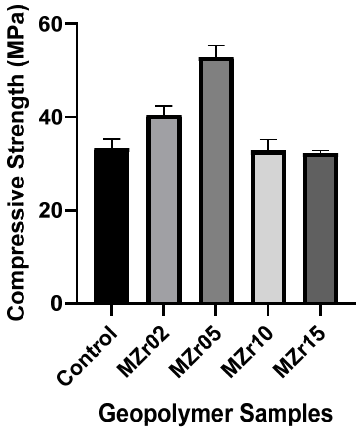
Figure 4. Compressive strength of geopolymer